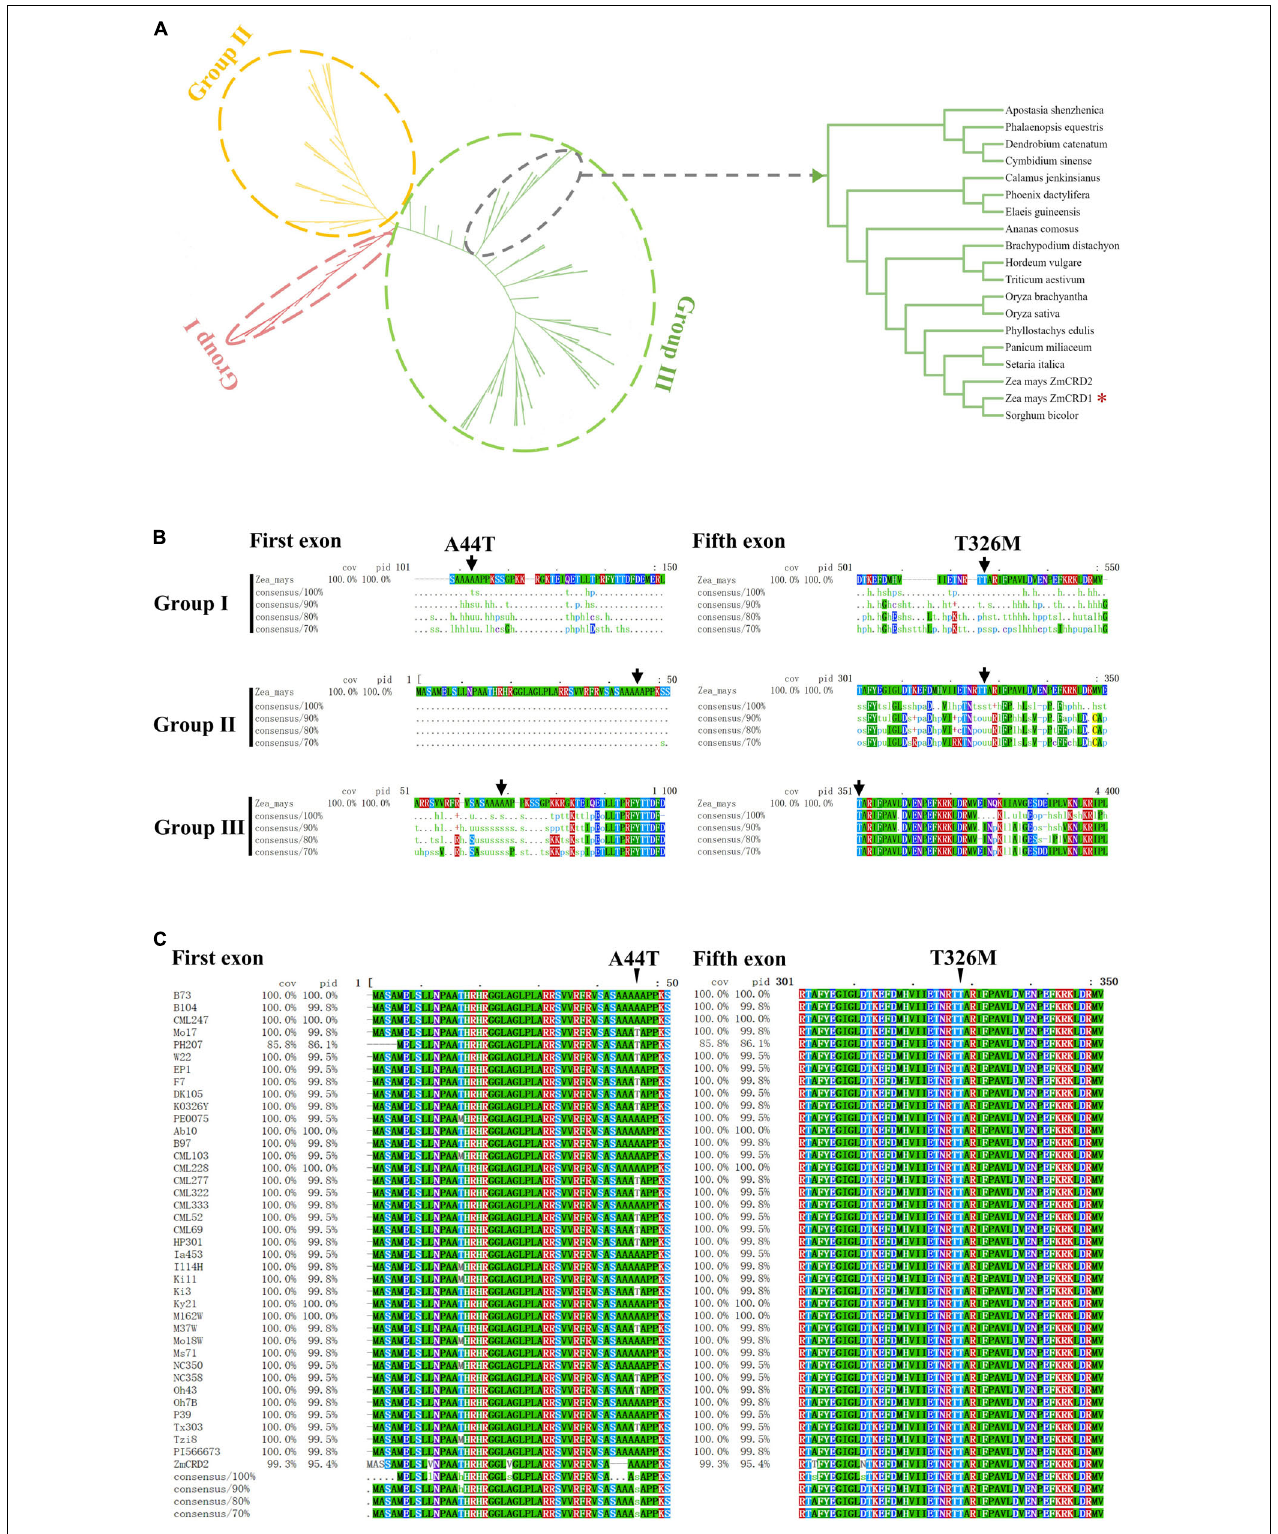
FIGURE 4 | The conservation and phylogenetic analysis of CRD1. (A) Phylogenetic analysis of ZmCRD1 and its 168 homologous proteins. The right image is an enlarged view of 18 CRD proteins containing ZmCRD1. The detailed annotated information of 18 CRD proteins is available in Supplementary Table 7 . (B) Multiple sequence alignment of ZmCRD1 and its homologous proteins within each subgroup. The arrows point to the p.A44 and p.T326 sites of ZmCRD1. (C) Multiple sequence alignment of ZmCRD1 in 37 maize inbred lines. The arrows point to the p.A44 and p.T326 sites of ZmCRD1.